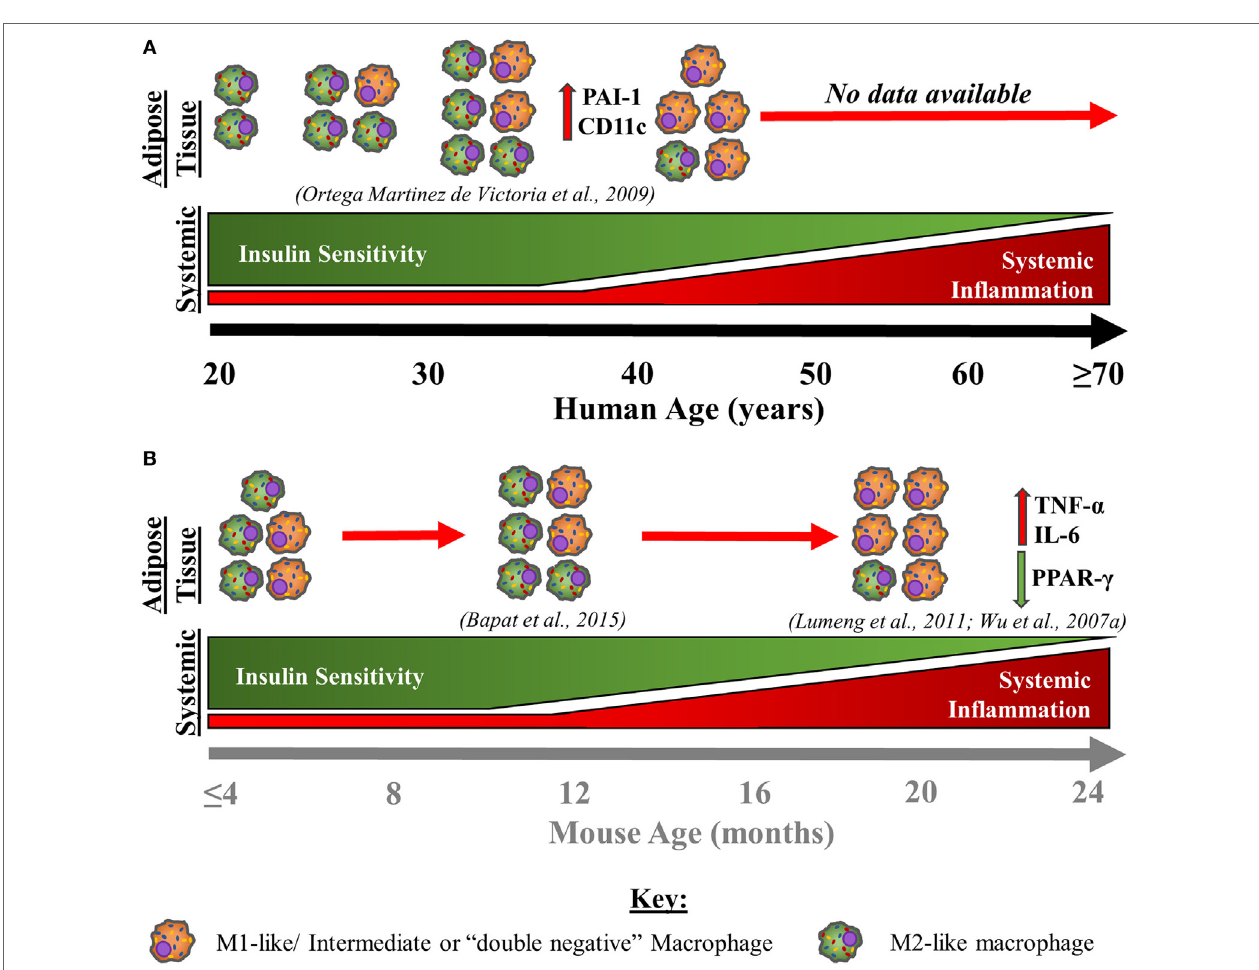
FiGURe 4 | Age-associated changes in adipose tissue macrophages and immunometabolic health in humans (A) and mice (B) . This schematic is a theoretical representation based on the limited empirical evidence that is available. With advancing age in humans (A) , subcutaneous adipose tissue macrophage content increases steadily until 31–33 years whereupon numbers slightly decline, until 45 years old (174). Although absolute adipose tissue macrophage content declines from around the age 31–33 years old until 45 years old, at least, the presence of more pro-inflammatory activated macrophages [M1-like/intermediate, or “double-negative” (CD11c − CD206 − ) macrophages] increases, which is associated with a decline in insulin sensitivity. With advancing age, insulin sensitivity continues to decline, while low-grade systemic inflammation begins to steadily increase from middle age into old age. With advancing age in mice (B) , an increase in pro-inflammatory macrophages within visceral adipose tissue that produce TNF- α and IL-6 and have downregulated PPAR- γ expression is also observed up to 18–24 months, at least (51, 170). Further, in middle-aged mice (44 weeks old), “double-negative” (CD11c − CD206 − ) and M2-like macrophages are largely unchanged or are modestly elevated, while M1-like macrophages exhibit a slight decline (172). Therefore, it is theorised that there is a continued pro-inflammatory macrophage activation/polarisation with advancing age in humans, independent of changes in absolute counts within the adipose tissue. Further, the same pattern of events appears to occur within murine adipose tissue, although the age at which this shift to a pro-inflammatory bias occurs is unknown. The similarities between data from aged mice and humans indicate that macrophages adopt a predominantly pro-inflammatory M1-like/intermediate, or “double-negative” (CD11c − CD206 − ) phenotype into old age, contributing to the increased systemic inflammation and impaired metabolic health exhibited by older individuals. Abbreviations: CD, cluster of differentiation marker; IL, interleukin; PAI-1, plasminogen activator inhibitor 1; PPAR- γ , peroxisome proliferator-activated receptor gamma; TNF- α , tumour necrosis factor- α